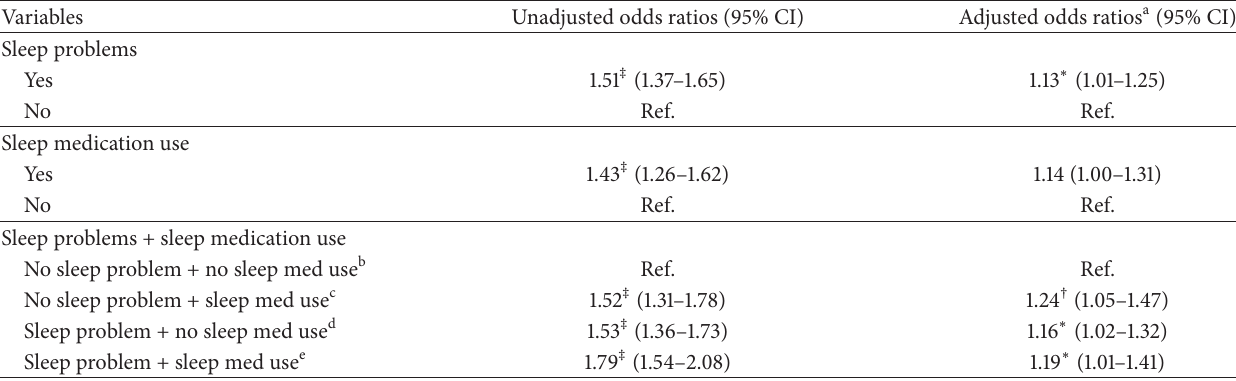
Table 3: Association between sleep problems, sleep medication use, and falls in community-dwelling older adults in the US, 2010. Variables Unadjusted odds ratios (95% CI) Adjusted odds ratios a (95%